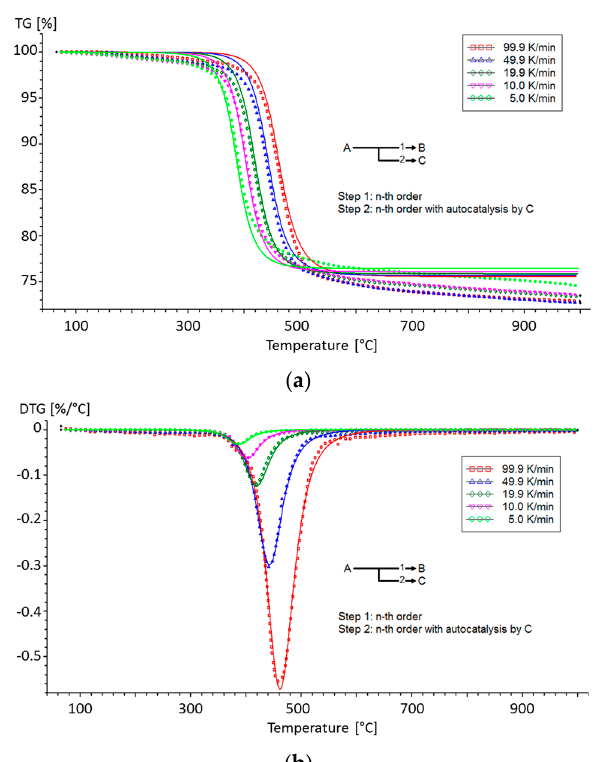
Figure 3. ( a ) Thermogravimetric curves and ( b ) differential thermogravimetric curves of the kinetic decomposition model with a physical meaning obtained using NETZSCH Thermokinetic software for T700/M21 [6].